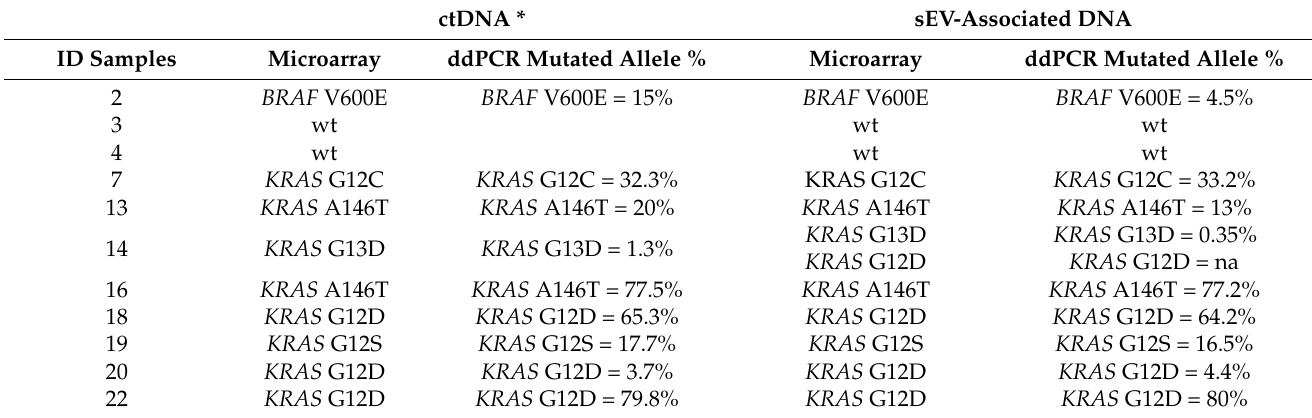
Table 1. Comparison of results obtained analyzing small extracellular vesicle (sEV)-associated DNA and ctDNA. ctDNA * sEV-Associated